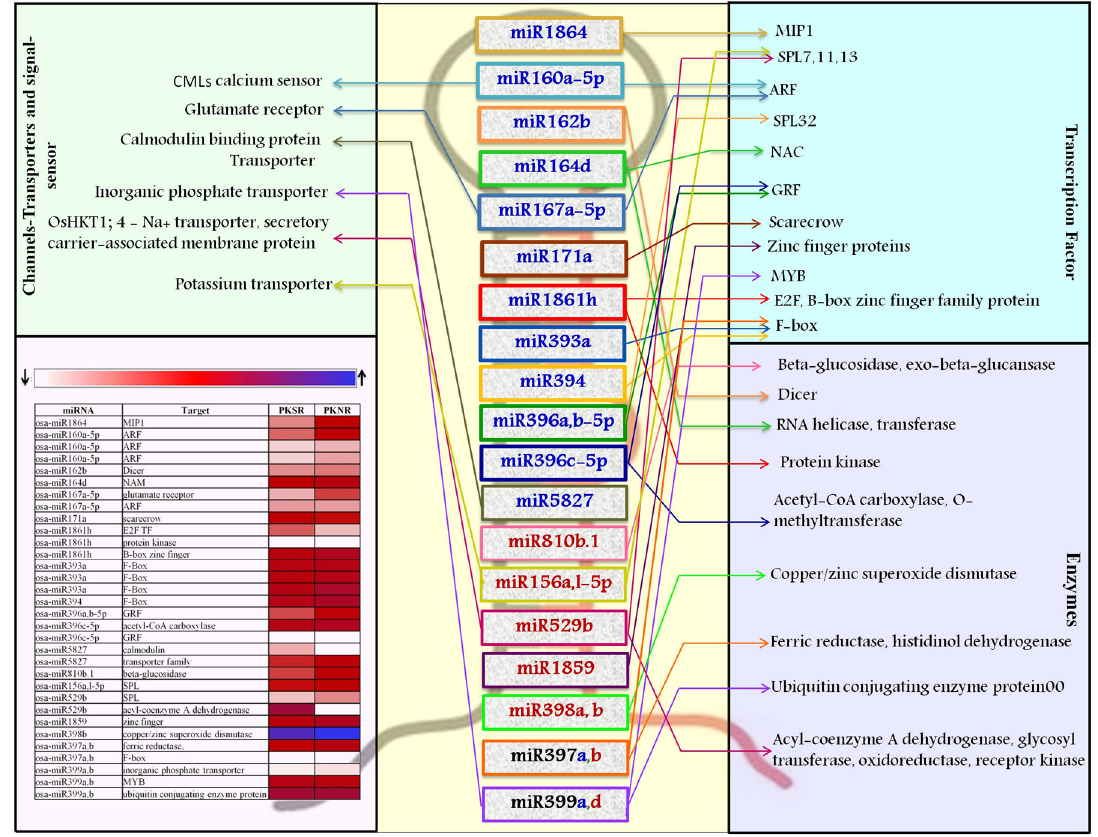
Figure 4. List of miRs that show stringent regulation in Pokkali root tissues grown in the presence of salt (PKSR) to modulate plant adaptability to the presence of salt. miRs up regulated in PKSR are indicated in blue. miRs down regulated in PKSR are indicated in red. The list of their predicted target transcripts indicates their functional role. Each miR:target node is depicted by its unique color code. The expression profile of targets is also shown.